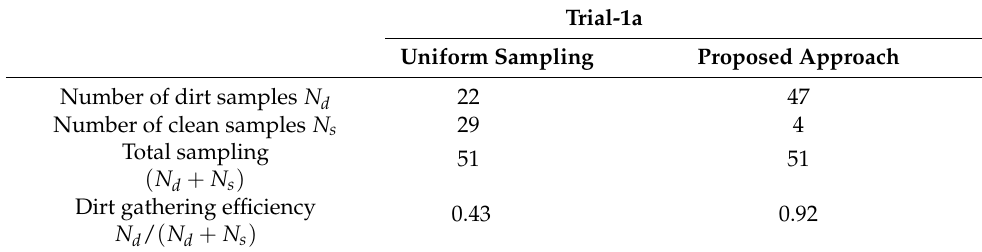
Figure 9. The environment chosen for trial-1.b ( a ), identified sample locations based on the proposed approach ( b ), dirt counts recorded corresponding to locations in a uniform grid sampling ( c ), dirt counts recorded corresponding to identified sample locations based on the proposed approach ( d ). Table 1. The sampling efficiency for a dirt count threshold 10 in